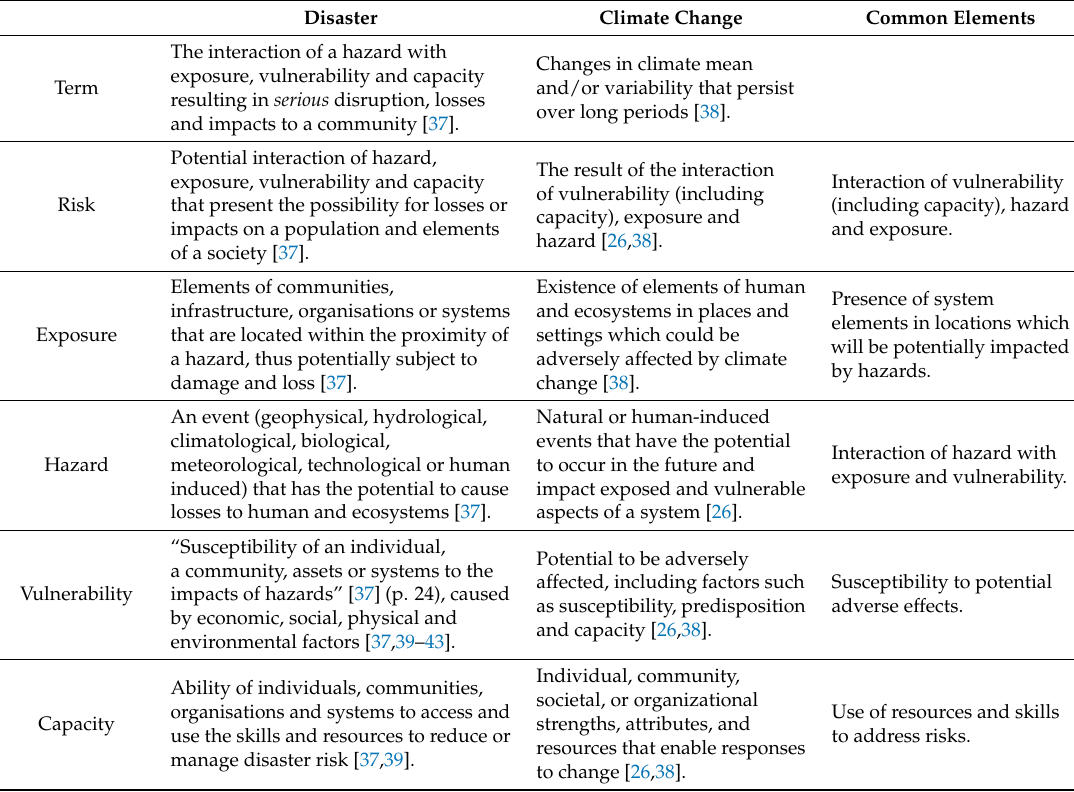
Table 1. Key terms related to disaster and climate change impacts on health. Disaster Climate Change Common